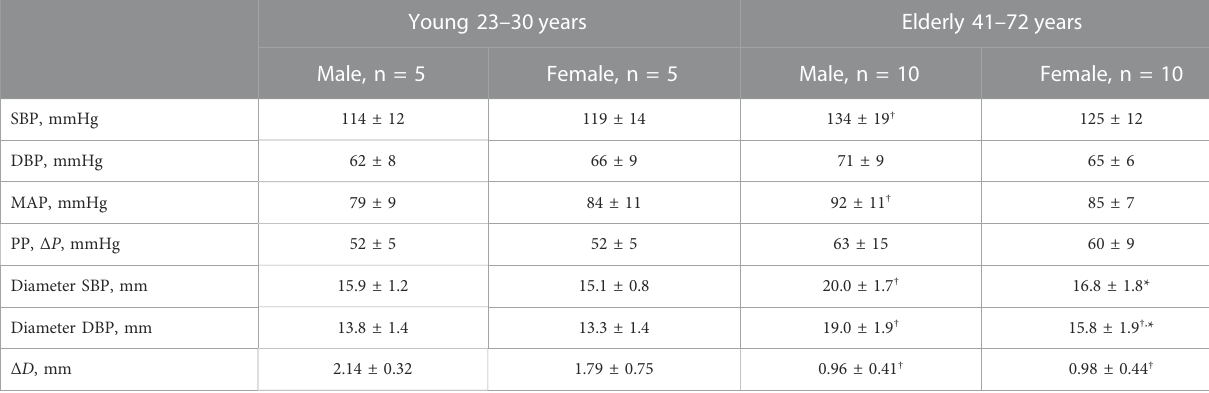
TABLE 3 Abdominal aortic pressure and